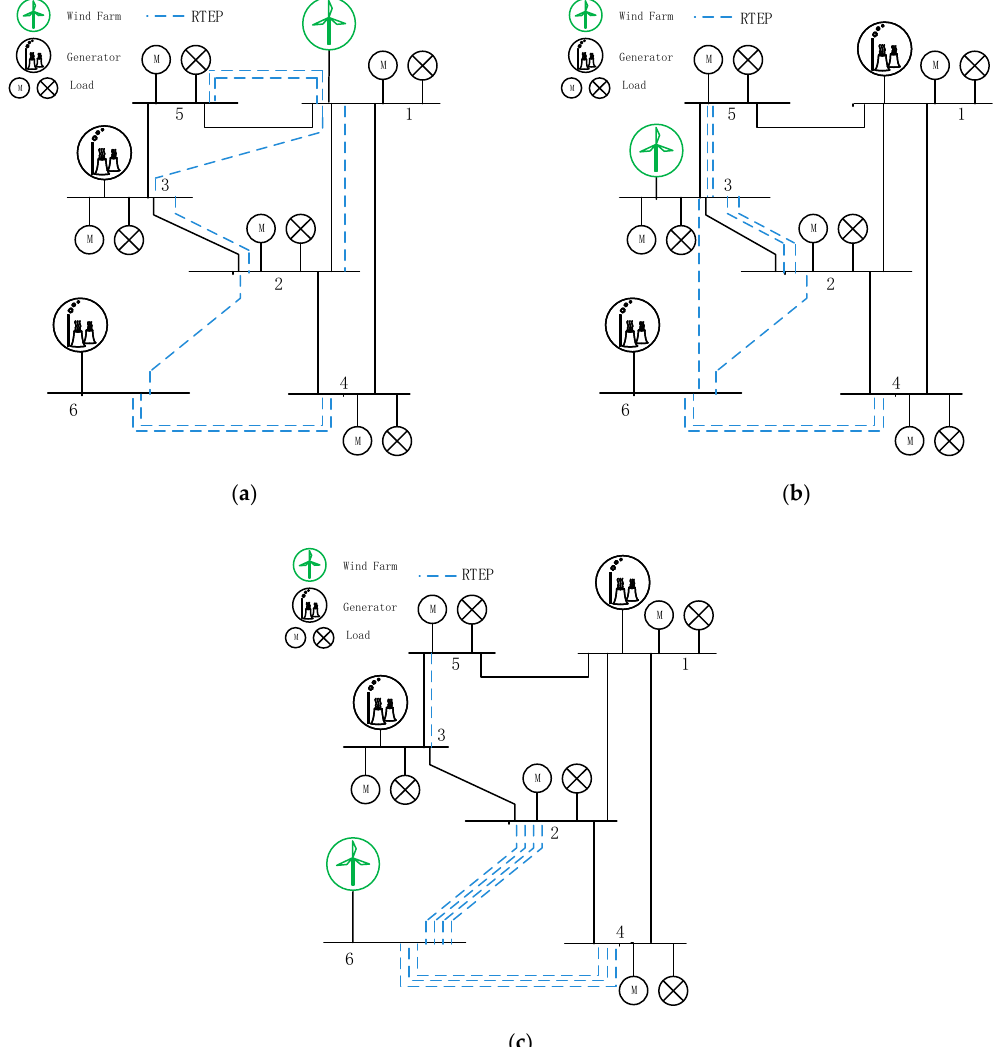
Figure 4. RTEP solutions obtained under different wind farm locations. ( a ) Wind farms located at bus # 1; ( b ) Wind farms located at bus # 3; ( c ) Wind farms located at bus # 6. # 1; ( b ) Wind farms located at bus # 3; ( c ) Wind farms located at bus #